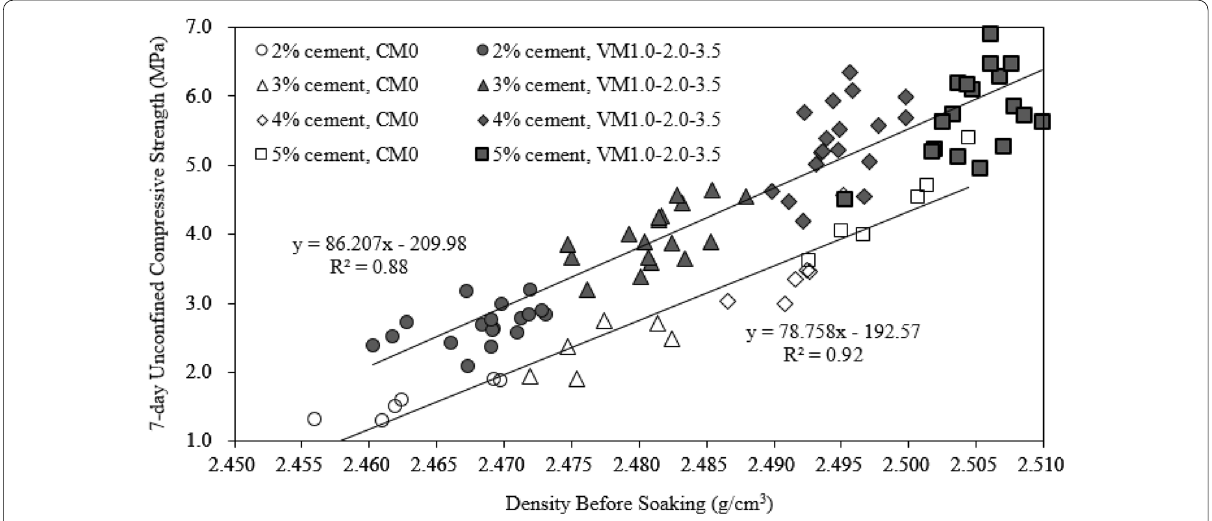
Fig. 8 7-Day UCS of CSM with four cement dosages in a function of the density before soaking.